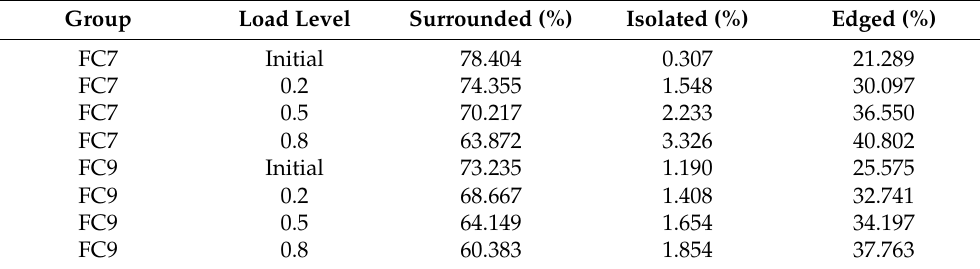
Table 2. Volume proportions of voids in different contact relationship under static loading. Group Load Level Surrounded